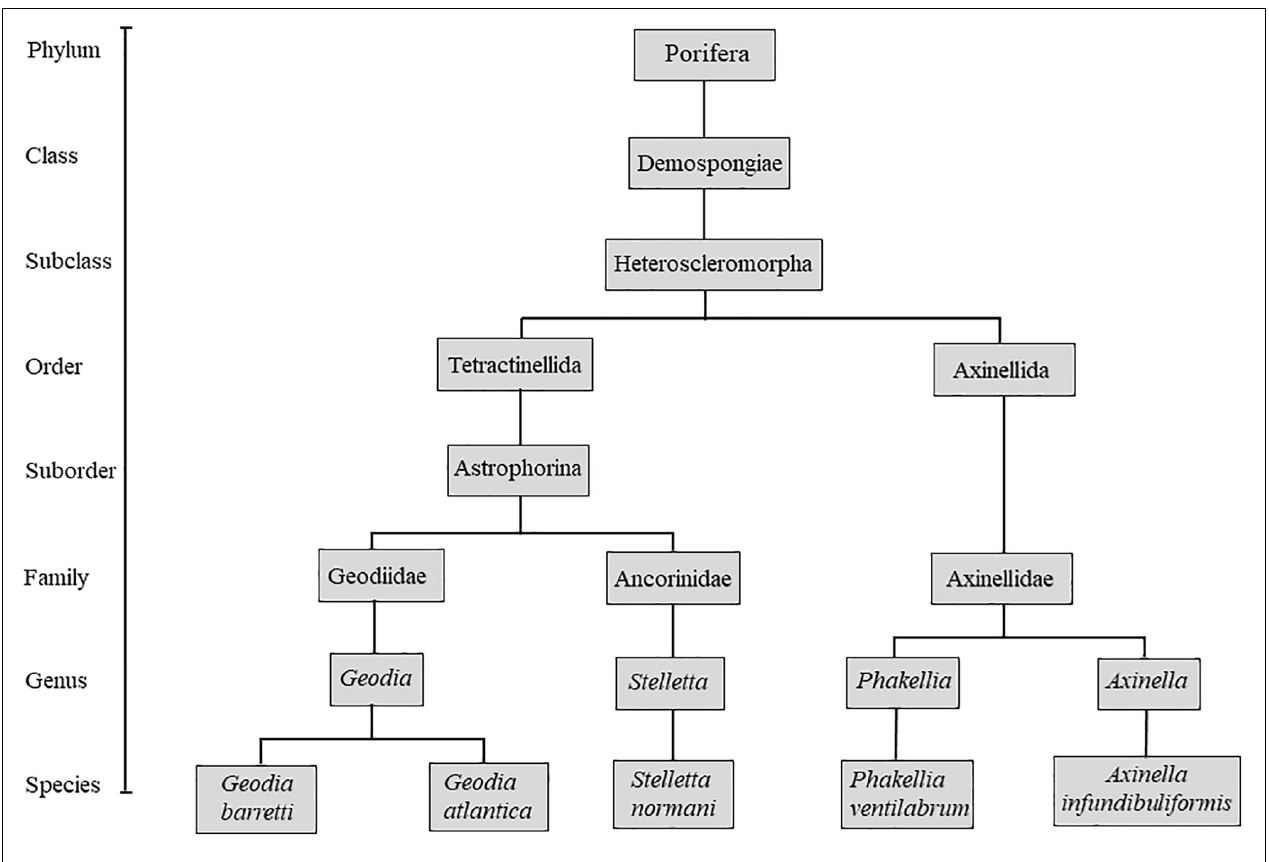
FIGURE 1 | Schematic taxonomic tree of the studied